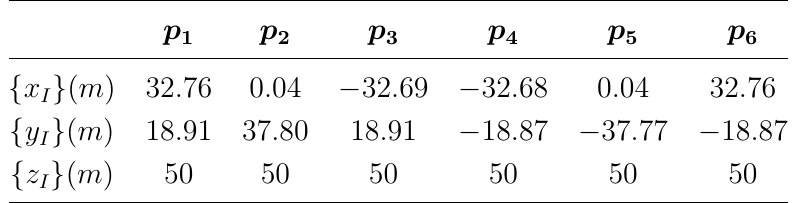
Table 2. Optimal sensor positions for σ = 0 . 05 rad , η = 0 . 1 and γ = 1